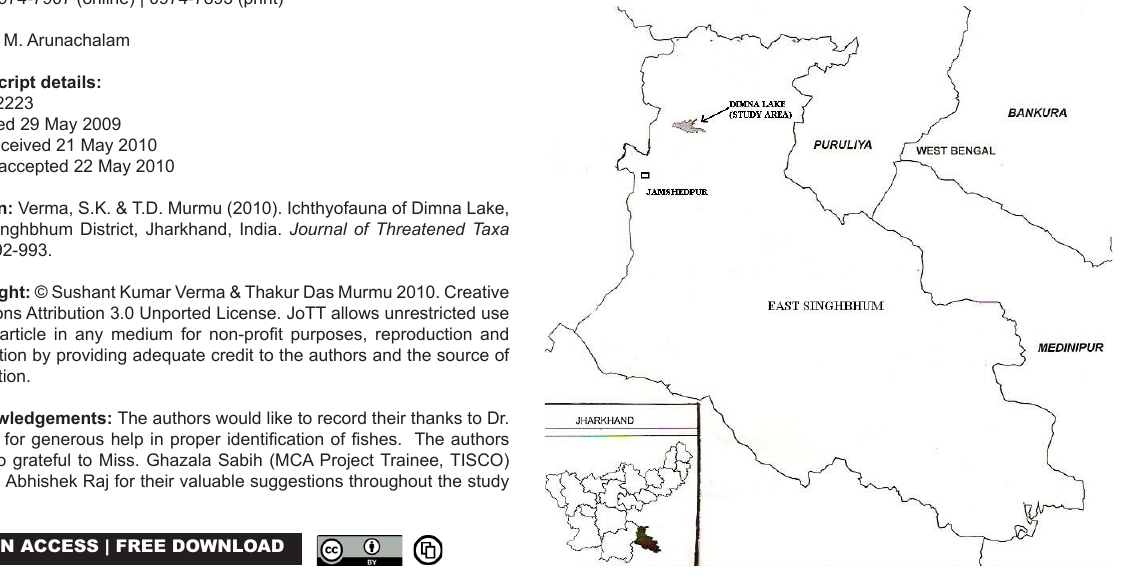
Figure 1. Map of the District East Singhbhum showing the study area (Dimna